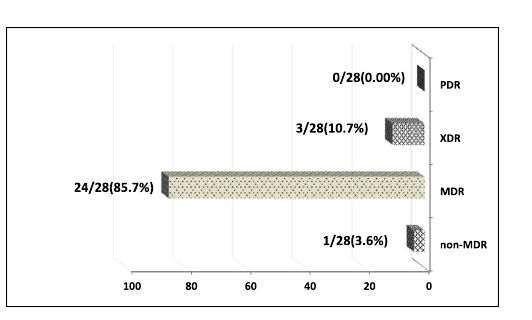
Fig. 2. Antibiotics resistance patterns among Enterococcus